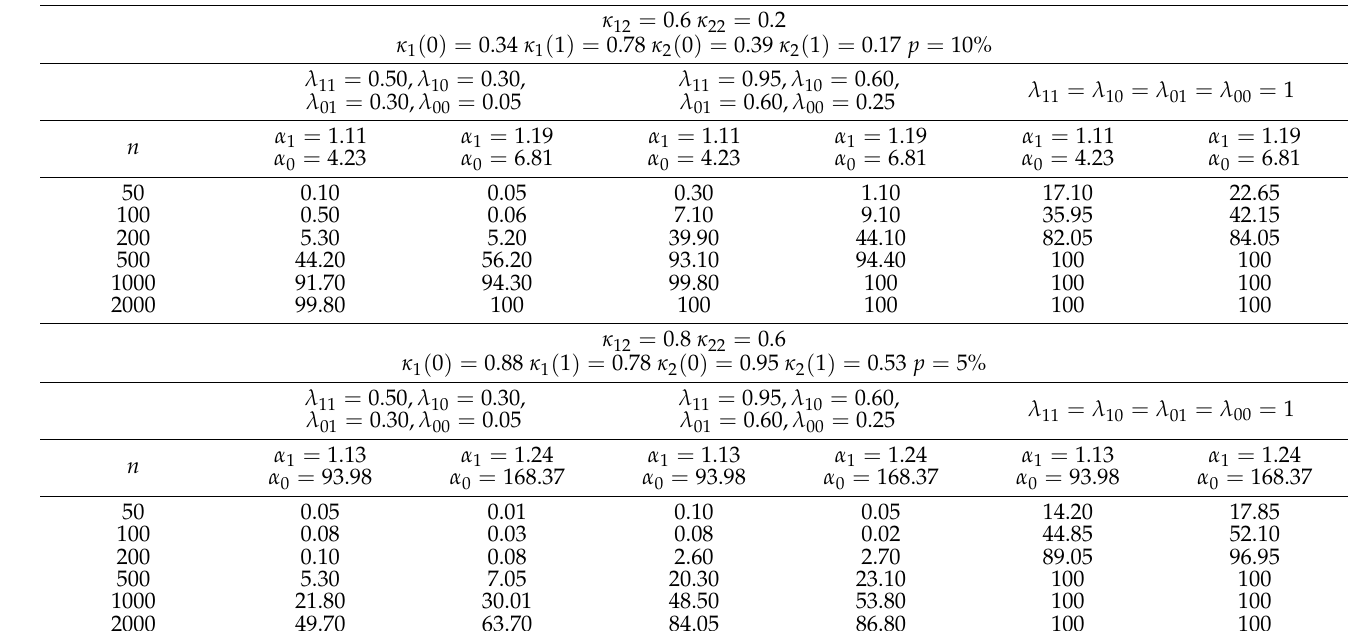
κ 12 = 0.6 κ 22 = 0.2